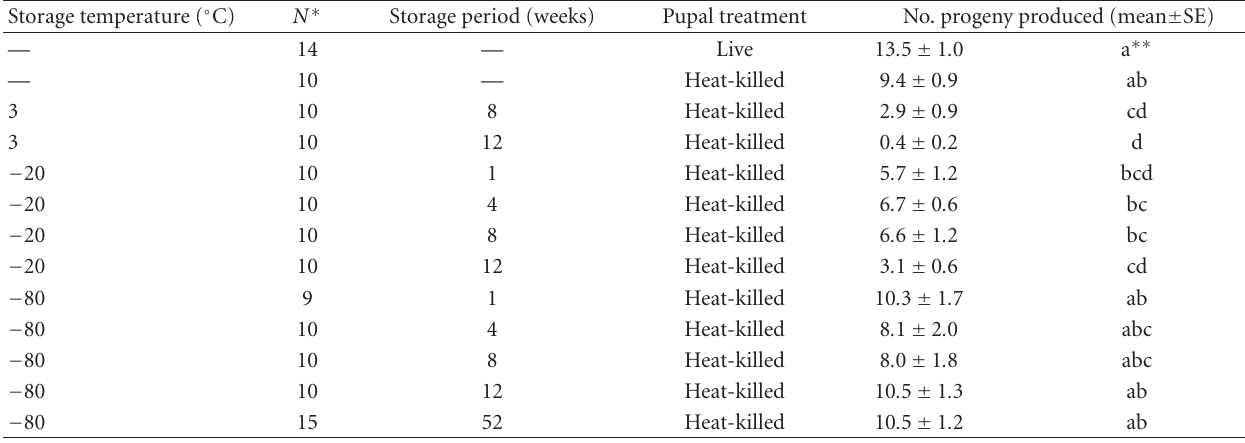
Table 3: Progeny production of S. endius on house fly pupae treated with di ff erent temperatures and storage periods after heat treatment. Storage temperature ( ◦ C) N ∗